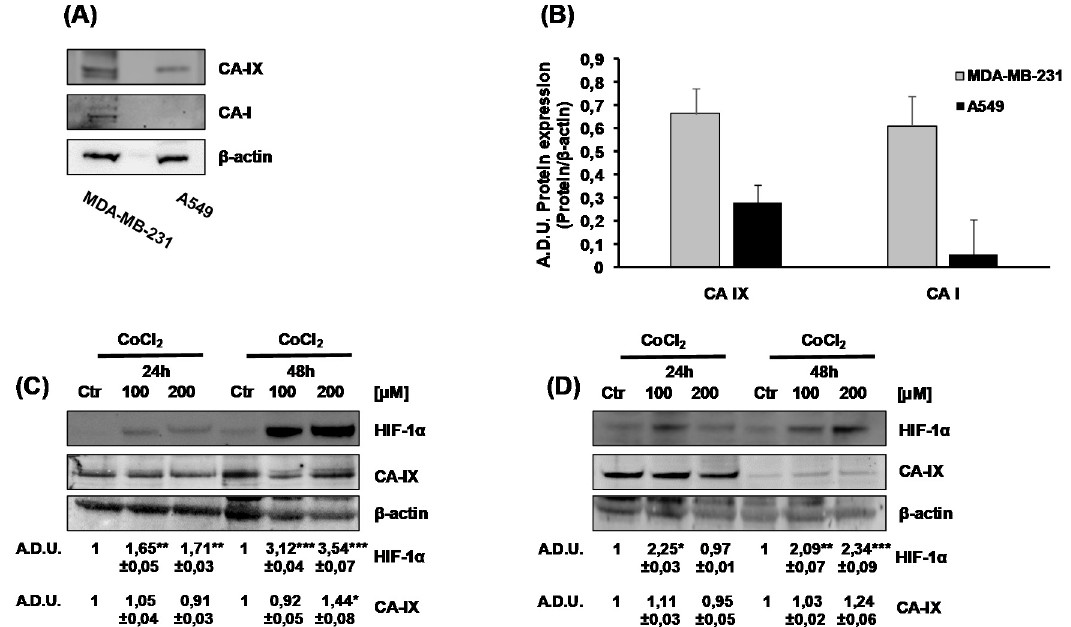
Figure 1. Carbonic anhydrase IX (CA-IX) and CA-I basal expression in MDA-MB-231 and A549 cells. ( A ). Protein expression of CA-IX and CA-I in MDA-MB-231 and A549 cells cultured for 24 h in complete medium with 1% FBS. ( B ). Quantification of CA-IX and CA-I protein expression. β -actin was used to normalize loading. Arbitrary Densitometry Units (A.D.U.) ± SD were reported as protein of interest vs β -actin. ( n = 3). ( C , D ). HIF-1 α and CA-IX protein expression in normoxic and hypoxic conditions in MDA-MB-231 ( C ) and A549 ( D ) cells. Tumor cells were treated with increasing doses of CoCl 2 [100–200 µ M], under experimental condition of DMEM with 1% FBS, for 24 and 48h. Numbers represent protein quantification reported as Arbitrary Densitometry Units (A.D.U.) ± SD of the protein of interest / β -actin vs the basal control condition (Ctr). ( n = 3). * p < 0.05, ** p < 0.01 and *** p < 0.001 vs. untreated cells (Ctr).